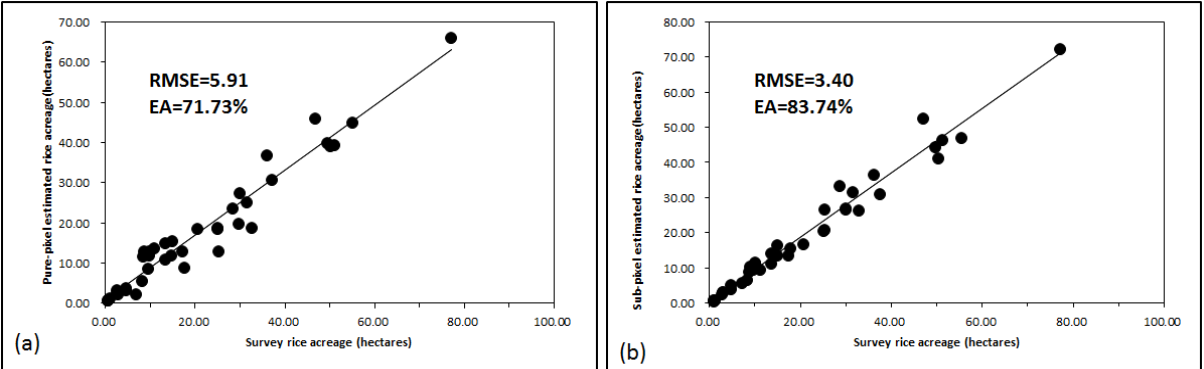
Figure 6. Pure-pixel, sub-pixel comparisons of late-season rice acreage estimated accuracy between estimated and survey